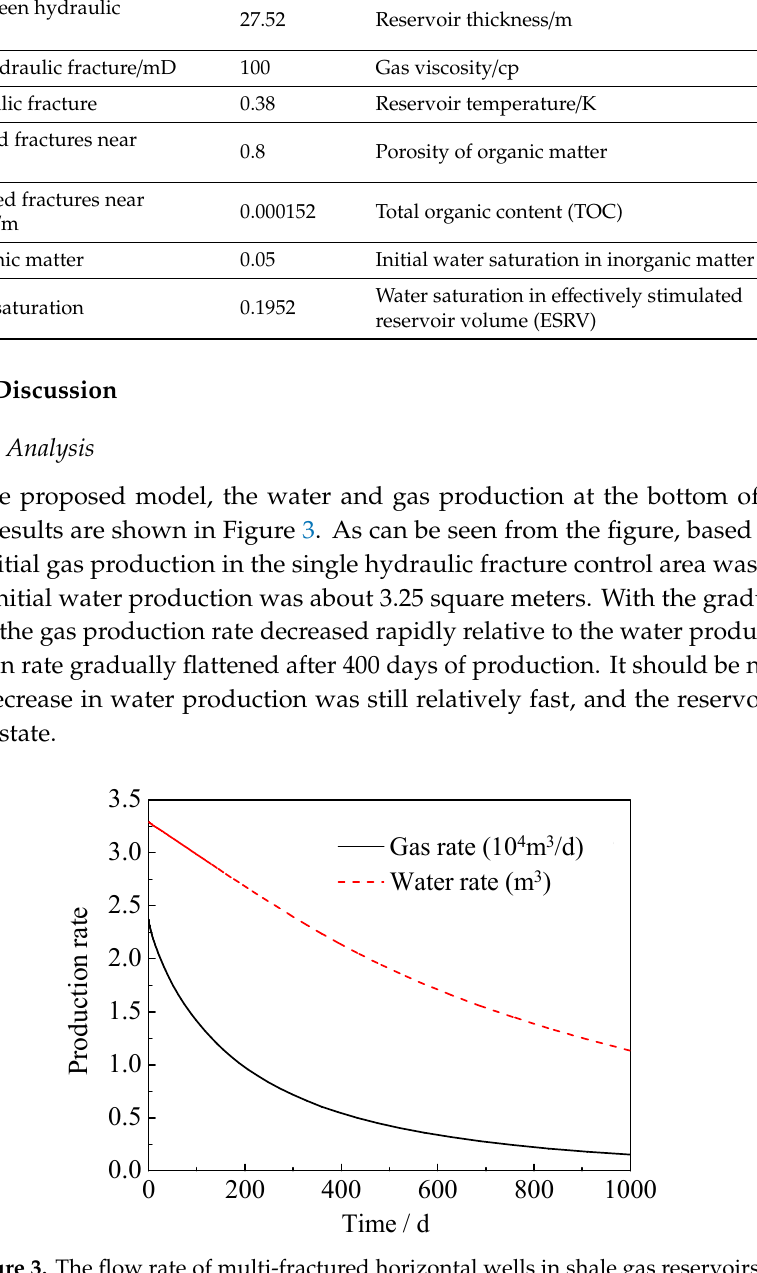
Figure 3. The flow rate of multi-fractured horizontal wells in shale gas reservoirs .